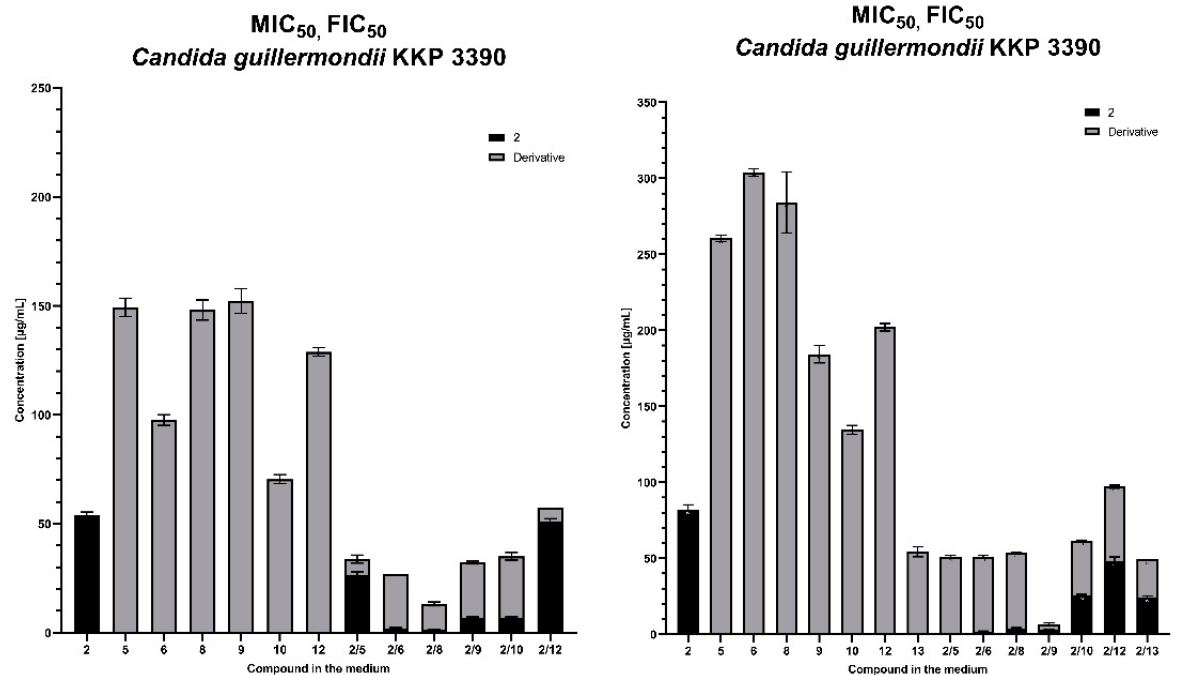
Figure 14. Comparison of MIC and FIC factors for selected azole derivatives and 3- n -butylphthalide against C. albicans ATCC 109231, C. albicans ATCC 2091, and C. guilliermondii KKP 3390.